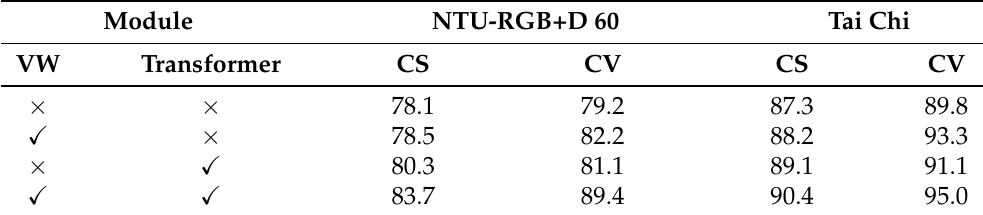
Table 2. Accuracy (%) comparisons on different modules on the NTU-RGB+D 60 dataset.